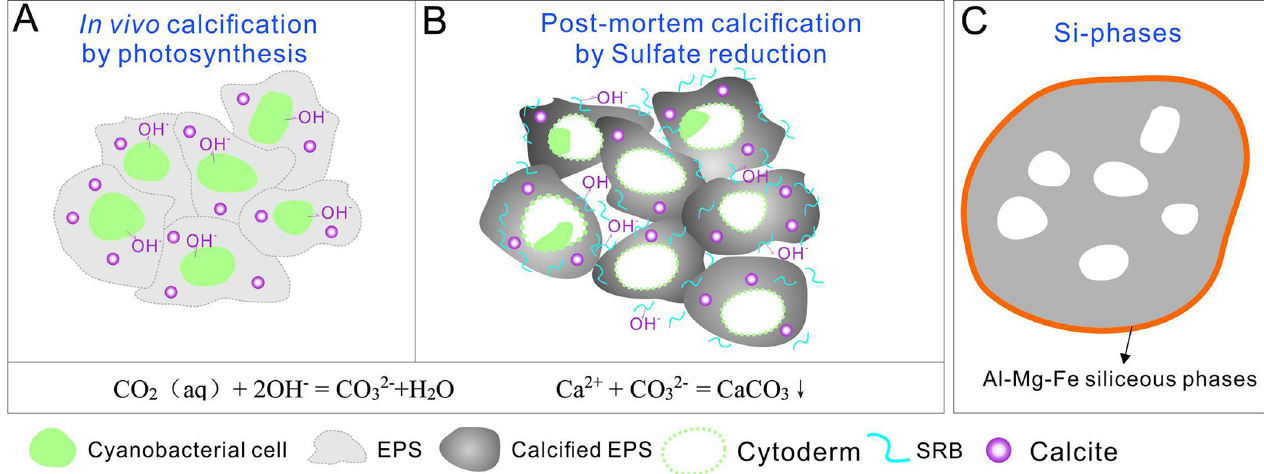
Fig 8. Capsule mineralization. (A) In vivo calcification for elevated alkalinity via photosynthesis. (B) Post-mortem calcification via sulfate reduction which leads to the alkalinity produced by the metabolism of sulfate reducing bacteria. Chemical equation showing how rising alkalinity contributes to precipitation. (C) Authigenic Al-Mg-Fe silicate minerals that encase the capsule.